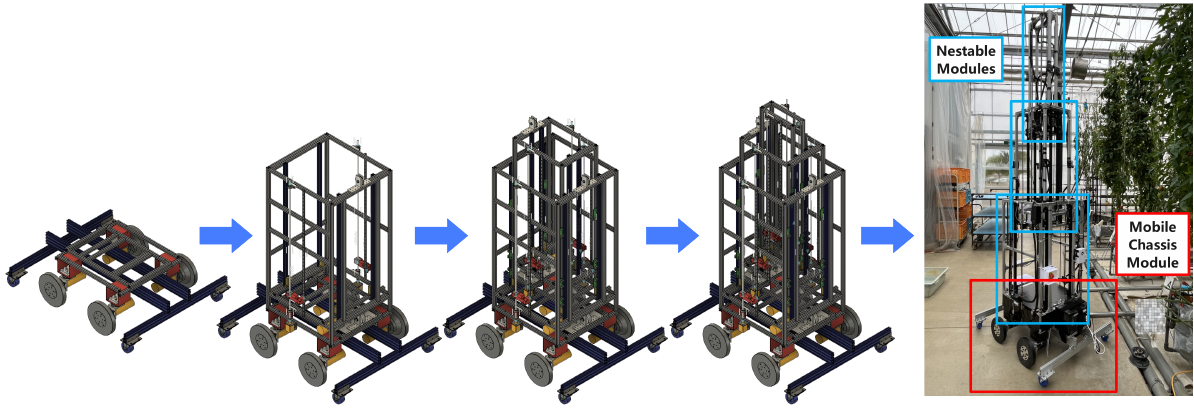
Figure 6. Configurations of the robot. In addition to the necessary mobile chassis module, users can decide how many nestable modules they need. In the case of using three nestable modules, the robot can transform to about 3 meters, which means it can photograph tomatoes guided to 3 m